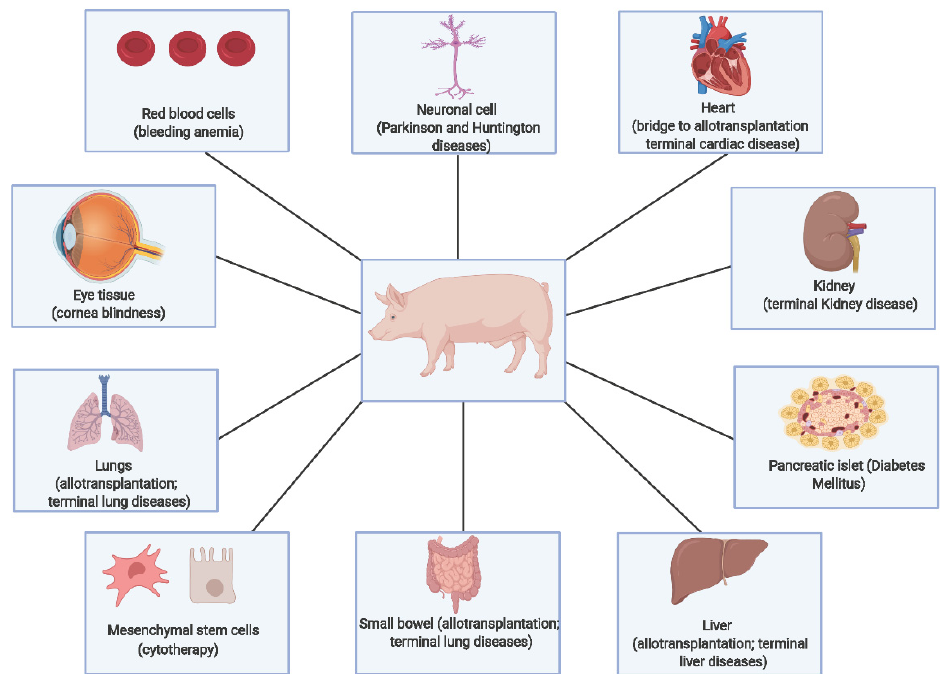
Figure 5. Potential applications of different pig organs and tissues in xenotransplantation. Adapted from Ekser et al. [90] . Created with BioRender.com (accessed on 9 March 2022).